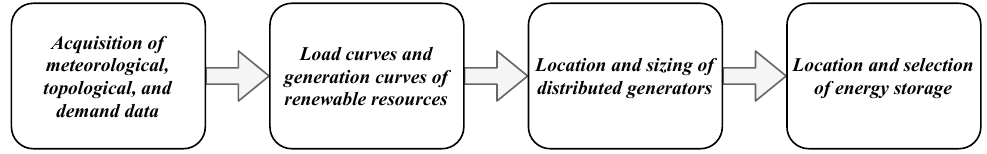
Figure 2. Stages of the methodology proposed for optimally integrating distributed energy resources into